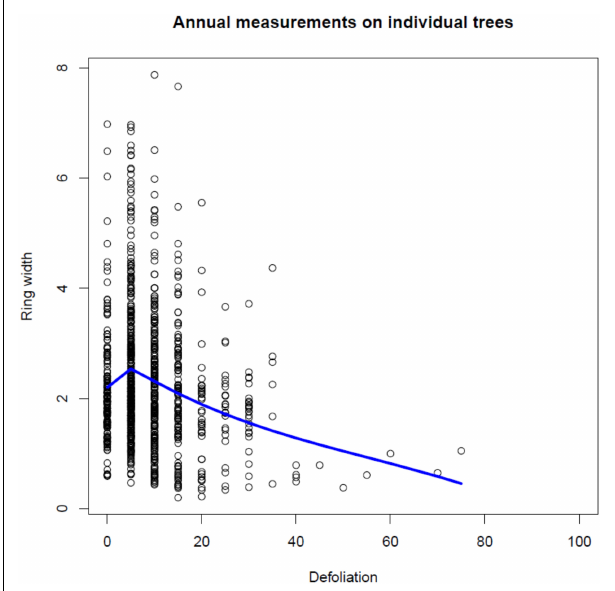
FIGURE 3 | Scatterplot of ring widths (mm) plotted against annual defoliation (%) for individual Norway spruce trees and a superimposed local linear regression curve.